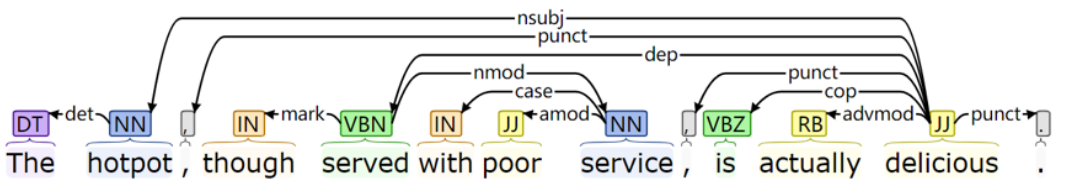
Figure 1. An example of a syntactic dependency parse tree. NN: noun. DT: determiner. IN: preposition or conjunction, subordinating. JJ: adjective or numeral, ordinal. nsubj: nominal